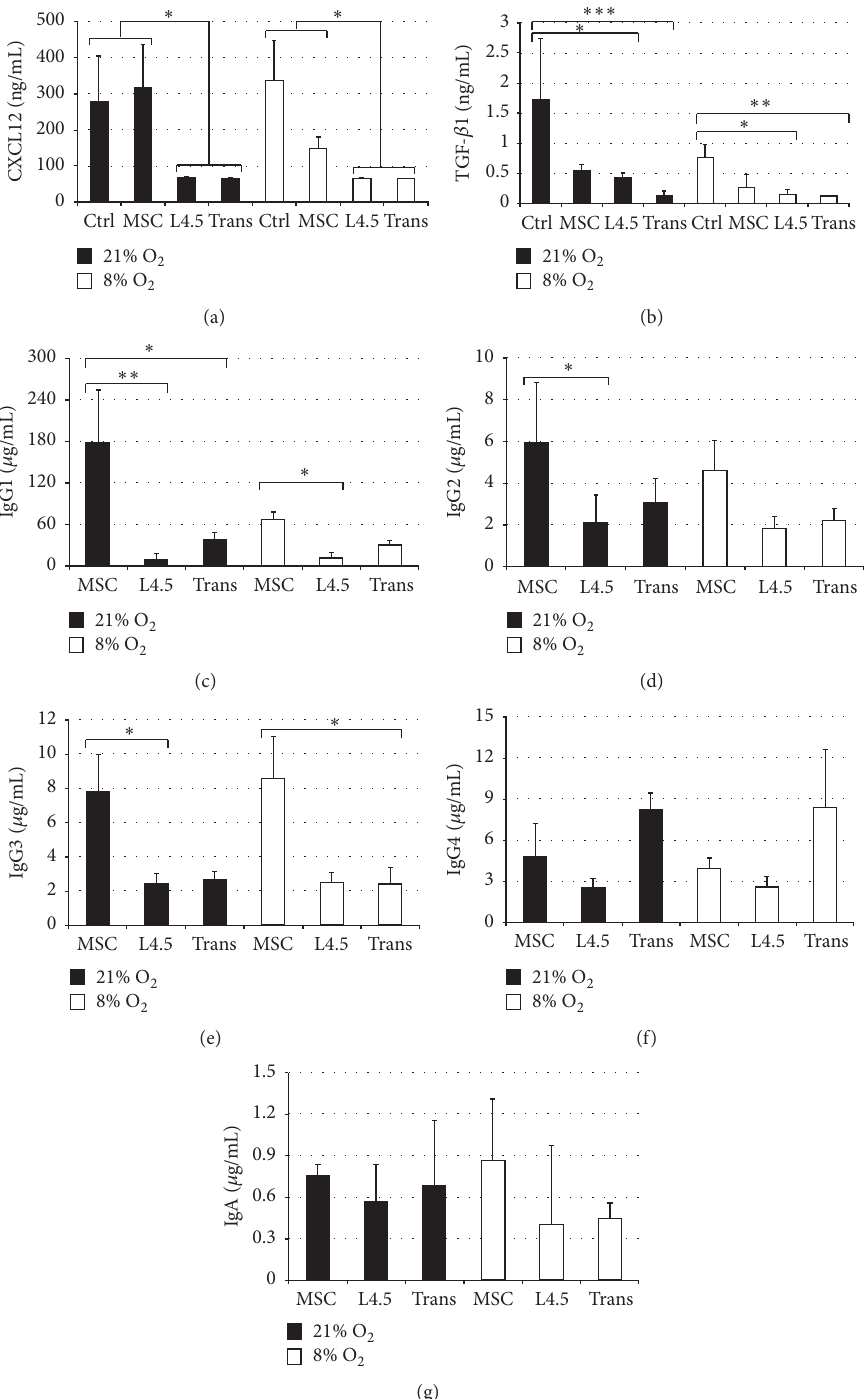
Figure7:Cytokinesandimmunoglobulinssecretions.Allanalysesweredoneattheendofthedifferentiationphase(day20).(aandb)CXCL12 and TGF- 𝛽 1 contents were determined in cell culture supernatants of differentiated cells. Control (Ctrl) corresponds to the supernatant of MSC cultured in 𝛼 -MEM for 4 days in the absence of B lymphocytes. All other conditions correspond to B lymphocytes in coculture with MSC or L4.5 cells or B lymphocytes cultured in the presence of MSC which were seeded in the upper chamber of transwell (Trans). Cultures were done in parallel and at 21% or 8% O 2 . (c–g) IgG1, IgG2, IgG3, and IgG4 secretion were determined in cell culture supernatants on day 20. Statistical analyses were performed using a Dunn multiple comparison 𝑡 -test ( ∗ 𝑝 ≤ 0.05 , ∗∗ 𝑝 ≤ 0.01 , and ∗∗∗ 𝑝 ≤ 0.001 ). No significant differences were observed between MSC in direct contact and transwell assays at 8% O 2 ( 𝑝 = 0.0556 ; Kruskal-Wallis 𝑈 -test). Except for the results of MSC in direct contact, which were obtained from four independent experiments, all data are from five independent experiments and all are presented as means ±